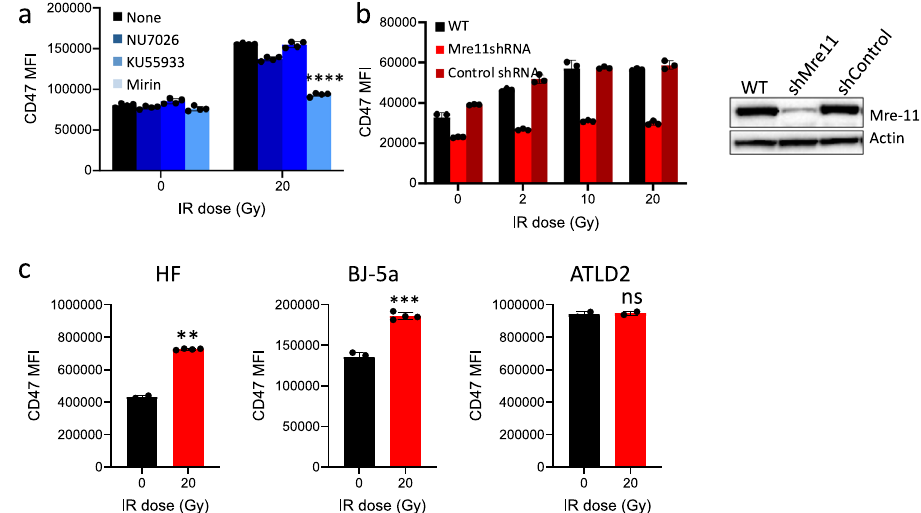
Fig. 4 Mre-11 dependent overexpression of CD47 in response to γ -irradiation. a HEK-293T cells were treated either with Nu7026 (10 µ M), Ku55933 (10 µ M), or mirin (100 µ M) and then exposed to γ -irradiation. Graphs depict CD47 expression (MFI) in HEK-293T cells at 24 h after irradiation. b Depletion of mre-11 by shRNA in 293T cells (right panel) abrogated CD47 upregulation upon γ -irradiation (left graph). c CD47 expression on HF, BJ-5a and ATLD2 cells in response to γ -irradiation. Graph shows an average (± STD) of four replicates in each group. Representative of three independent experiments is shown. ns: non-signi fi cant; ** p < 0.005; **** p <